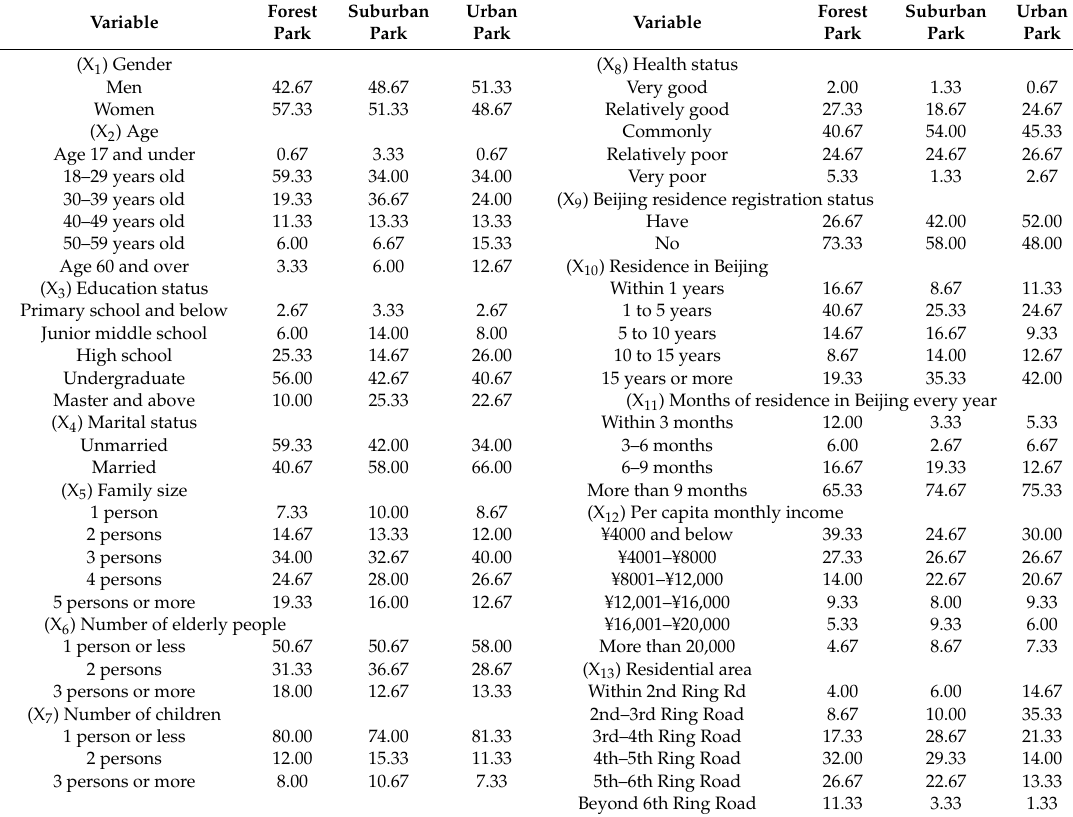
Table 1. Descriptive statistics of samples